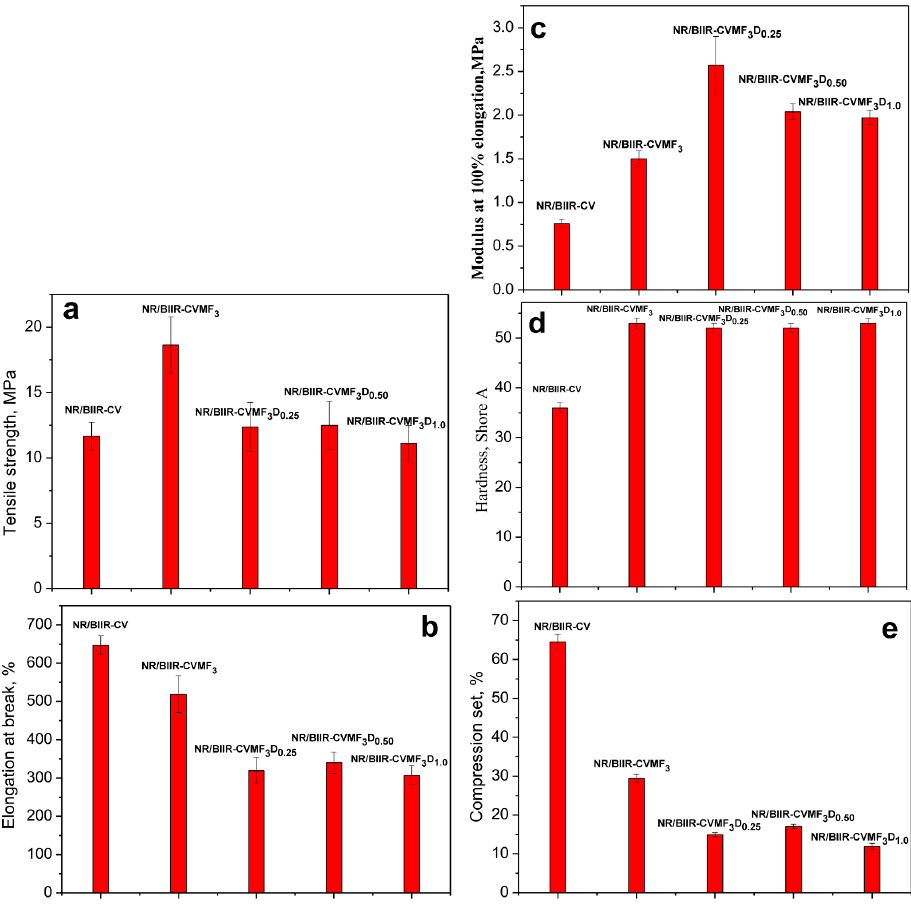
Figure 6. Mechanical properties of NR/BIIR-CVMF3 with different contents of DCP ( a ) Tensile strength; ( b ) Elongation at break; ( c ) Modulus at 100% elongation; ( d ) Shore-A Hardness; ( e ) Com- pression set.